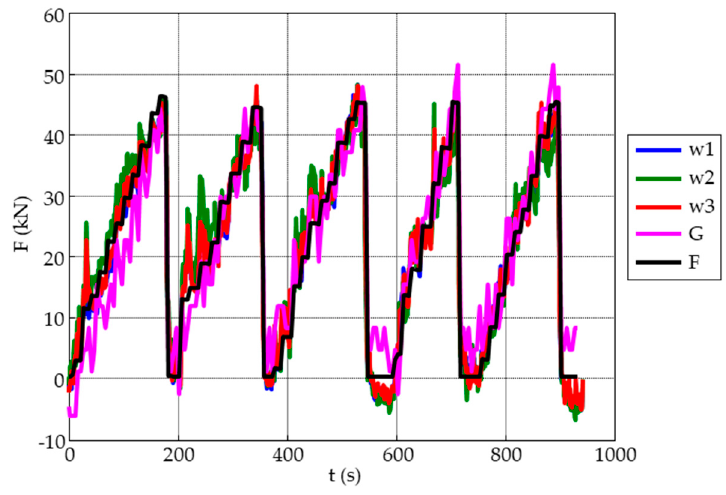
Figure 8. Forces measured for each embedded sensor during the loading/unloading test.